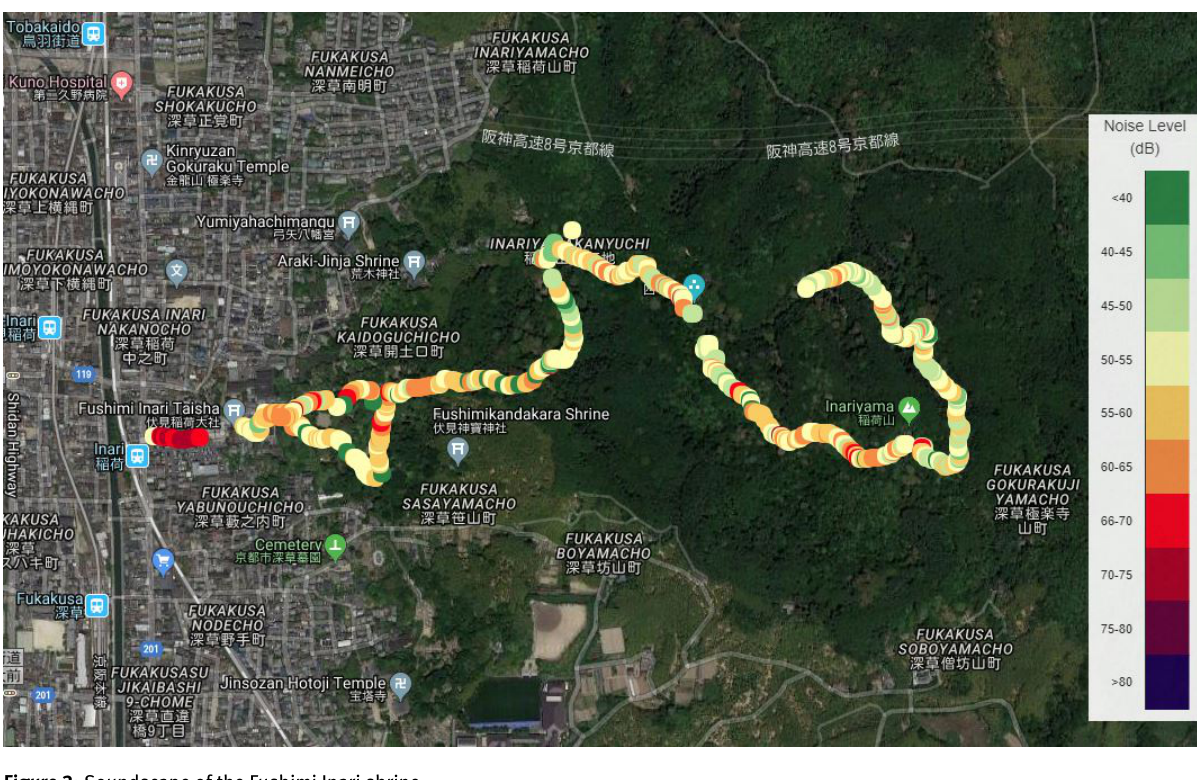
Figure 3: Soundscape of the Fushimi Inari shrine